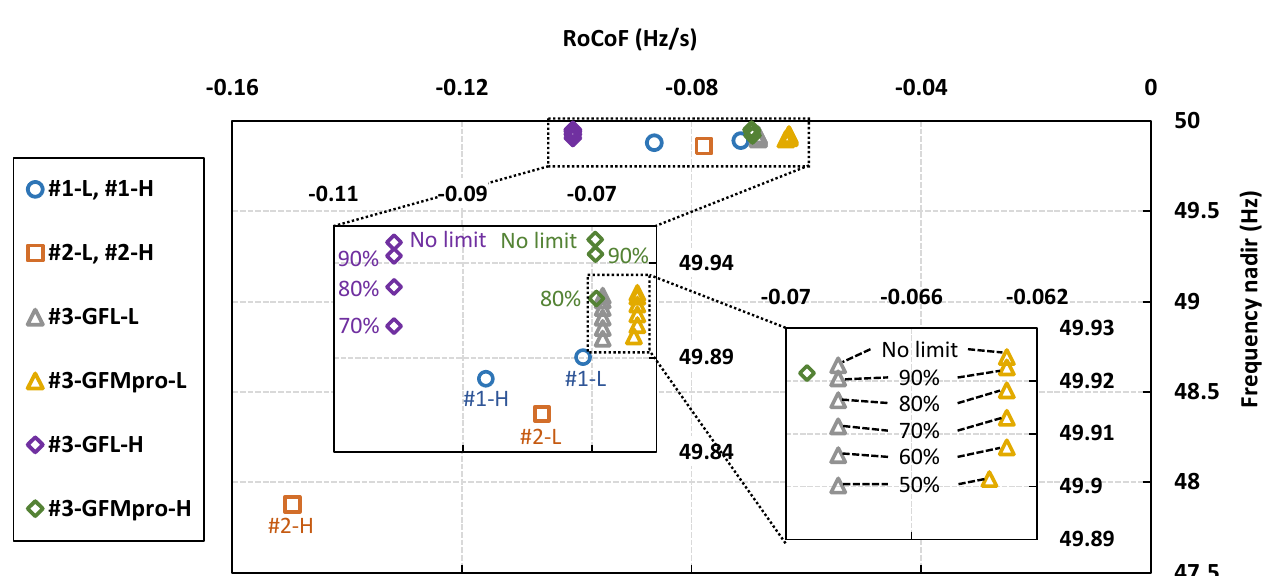
Figure 13. Correlation between RoCoF and the frequency nadir.